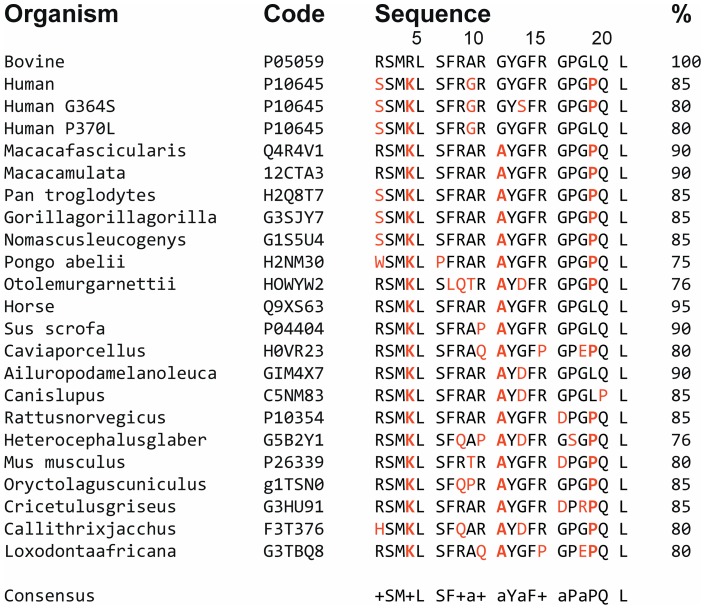
Sequence alignment of bovine catestatin (CgA344–364) with corresponding fragments from several species.For each position predominant identical residues are indicated in bold letters. Homology sequence is indicated (%).The data base used is UniProtKB. (+, basic residue; a, for A/G/T/P).